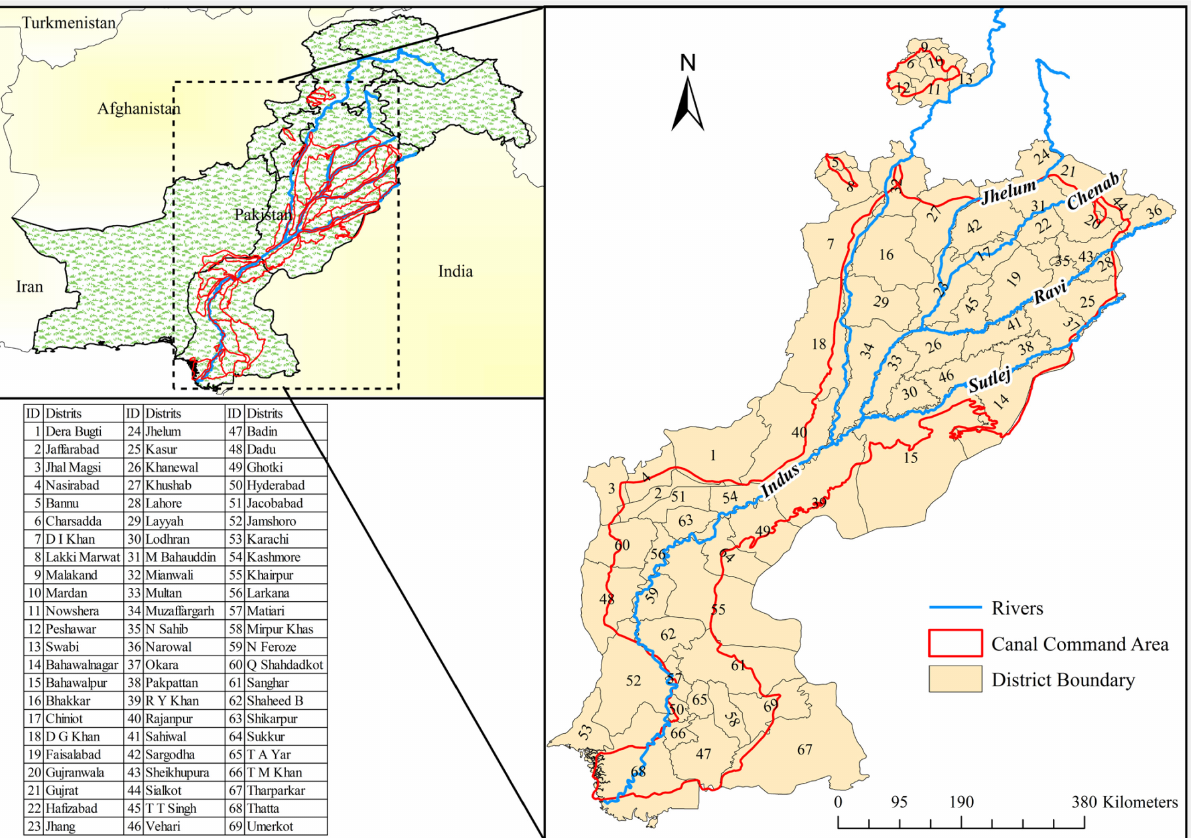
Figure 1. Geographic location of study